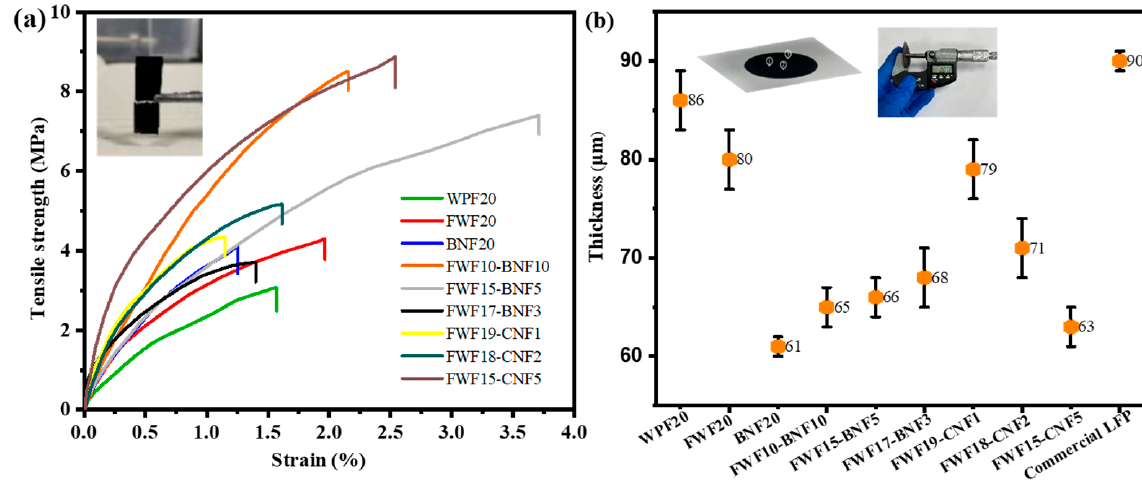
Figure 3. ( a ) Mechanical property curve of paper-based electrode; ( b ) Electrodes thickness.